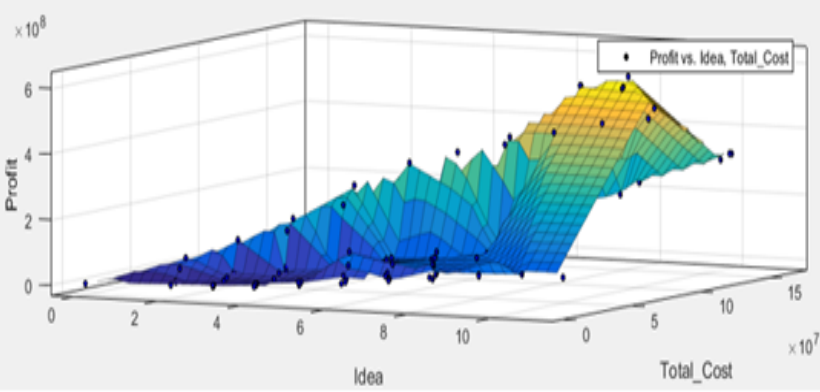
Figure 3. The curves of correlation between idea, total cost, and obtained profit in active SMES.